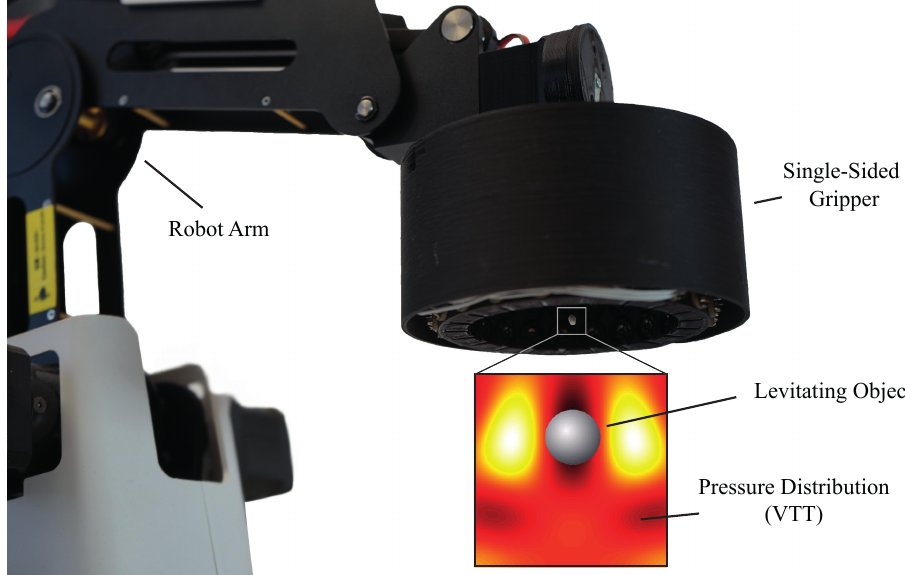
Figure 2. Single-sided gripper arrangement capable of picking objects from acoustically reflective and transparent surfaces using standing waves and vertical twin traps